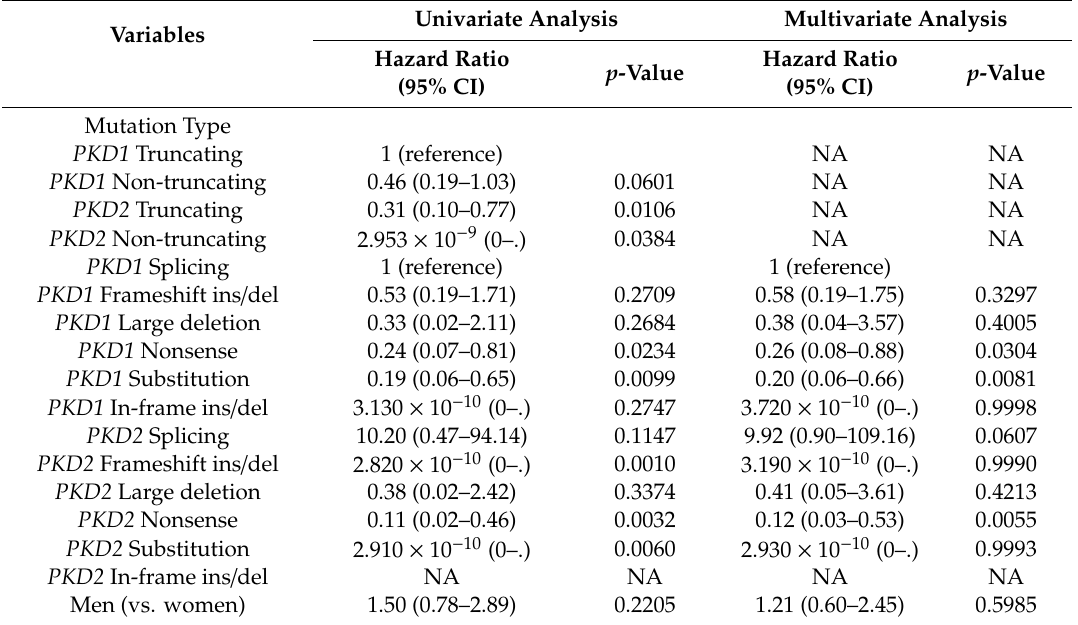
cohort (Figure 2a; log-rank, p = 0.0308). When the PKD1 cohort was divided into truncating and non- truncating mutations, the kidney survival rate was the lowest in patients with PKD1 T (Figure 2b; log- rank, p = 0.0144).